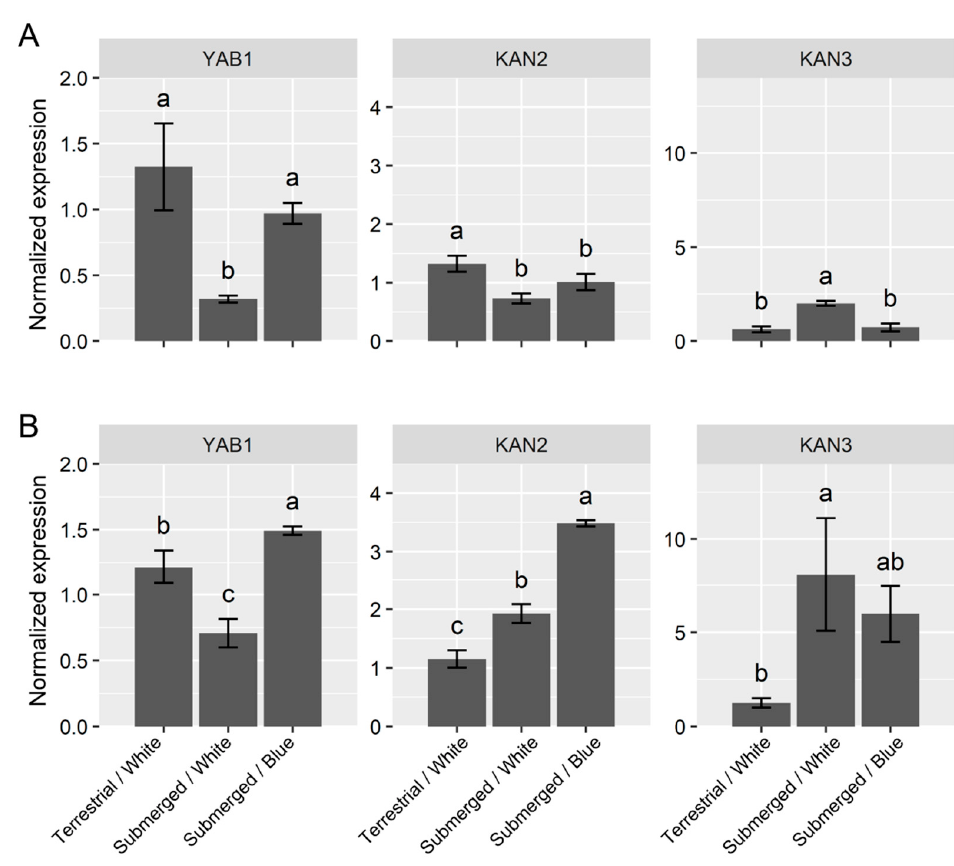
Figure 4. Expression profiles of the abaxialization genes after submergence. The plots indicate the relative expression normalized by ubiquitin5 (mean ± SE, n = 3) after 1 day ( A ) and 7 days treatment ( B ). The different letters denote significant differences among the experimental conditions (Tukey– Kramer test; the adjusted p -value < 0.05).